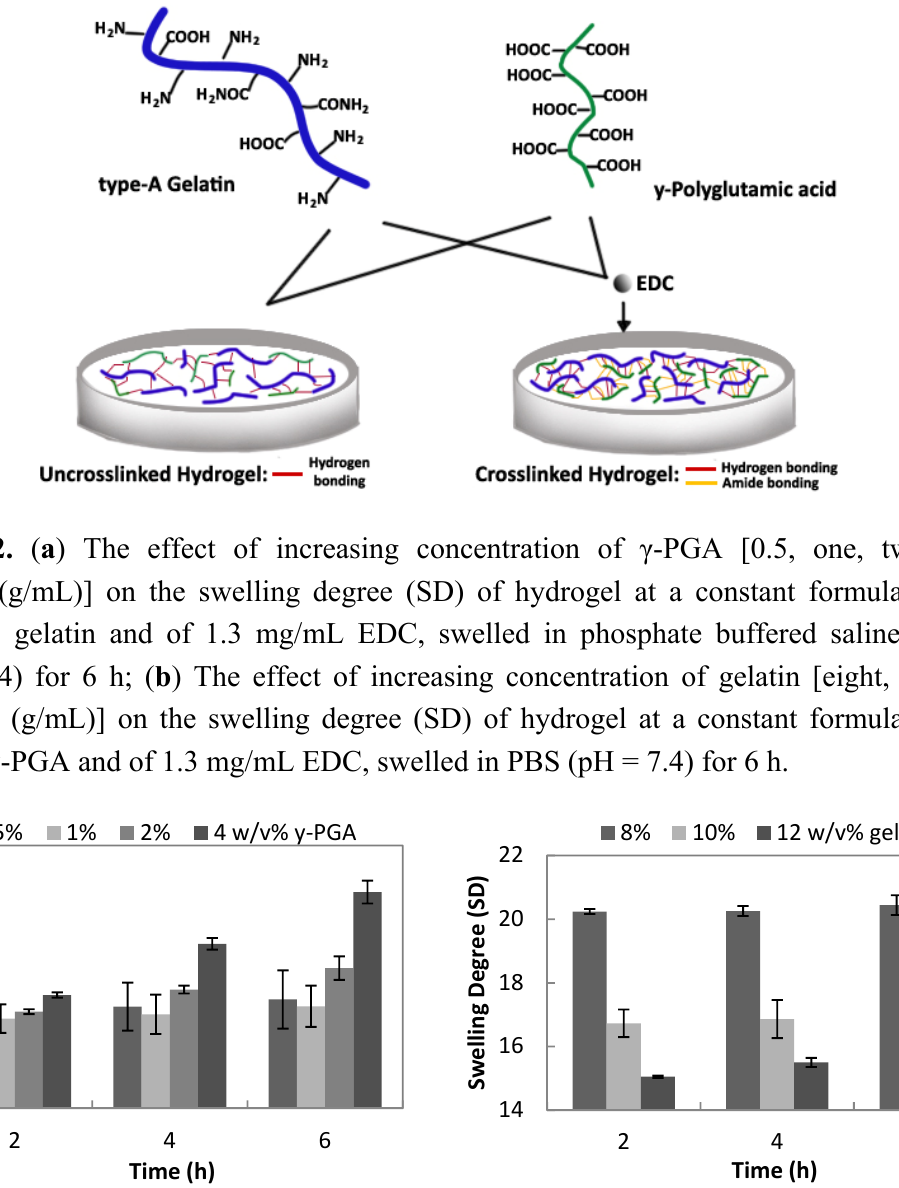
Figure 1. The effect of the crosslinker [ethylcarbodiimide (EDC)] on the ionic interaction of type-A gelatin and γ -Polyglutamic acid ( γ -PGA) for the synthesis of hydrogel at a pH = 7.4 and a temperature of 4 °C.